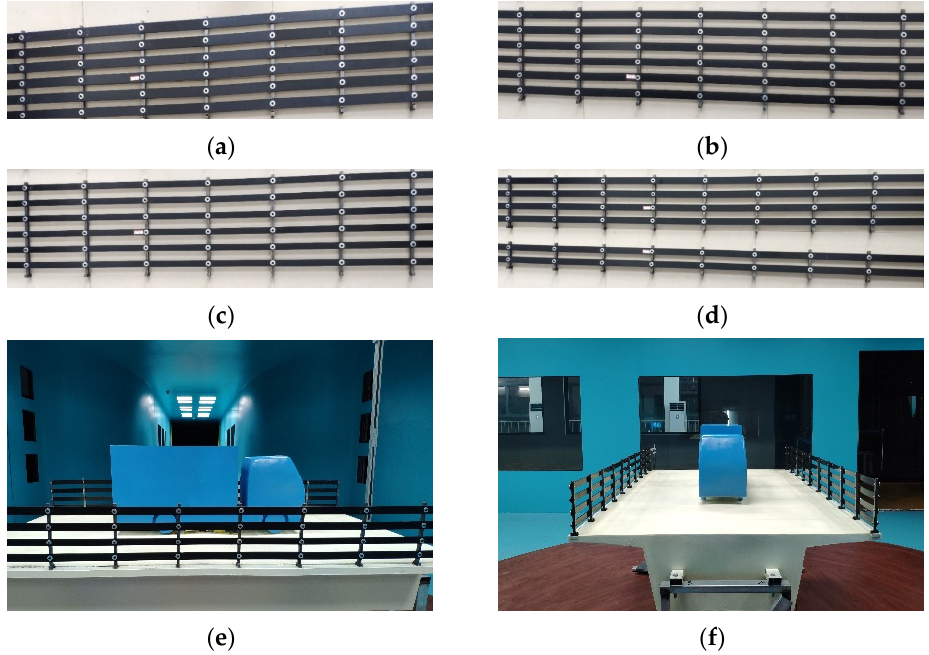
Figure 12. Wind barrier and wind tunnel test (( a ) Scheme 1; ( b ) Scheme 2-1; ( c ) Scheme 3; ( d ) Scheme 2-2 and Scheme 2-3); ( e ) side view the of wind tunnel test; ( f ) front view of the wind tunnel test.